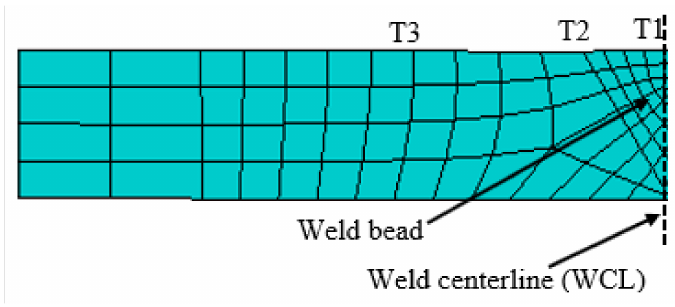
Figure 10. Thermal history